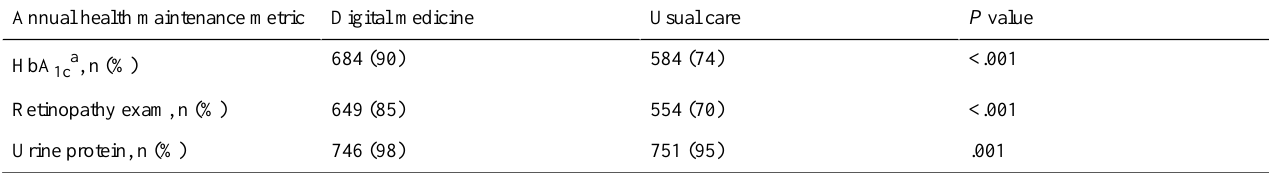
Table 5. Proportion of patients completing annual health maintenance in the digital medicine (n=763) and usual care (n=794)